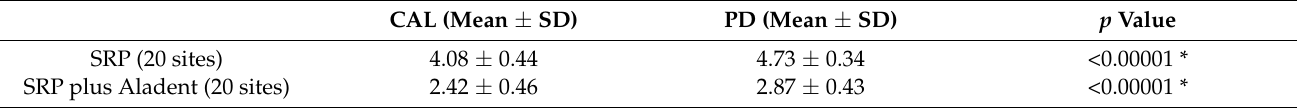
Table 3. CAL and PD values after treatment with SRP alone and SRP plus ALADENT: Results are statistically significant at * p value <